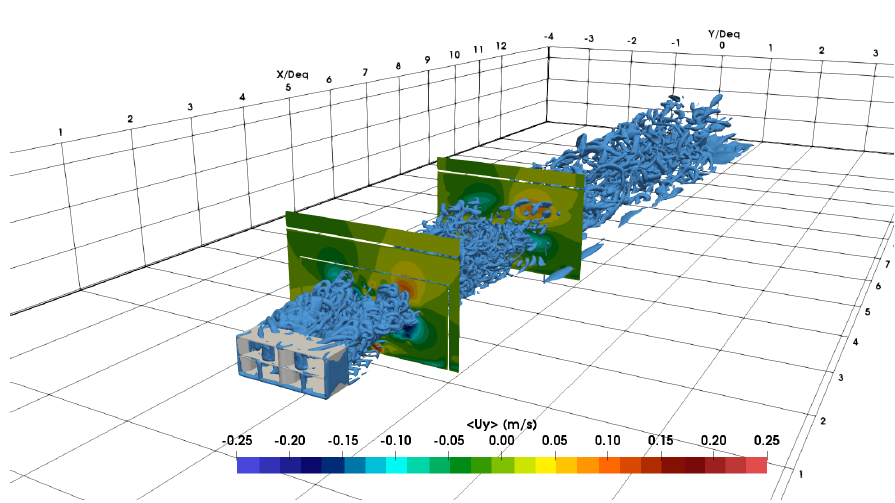
Figure 23. Average < U y > velocity planes at x / D eq = 1.2 and x / D eq = 4.2 in the wake of the turbine for an upstream turbulence rate of I = 0%. Dimensions are scaled by the equivalent diameter D eq = 25.0 m. Vortices are represented with instantaneous iso-contour of the Lambda 2 criterion, Lambda 2 = − 1.0 × 10 − 5 . x and y axis are centered at the turbine location.